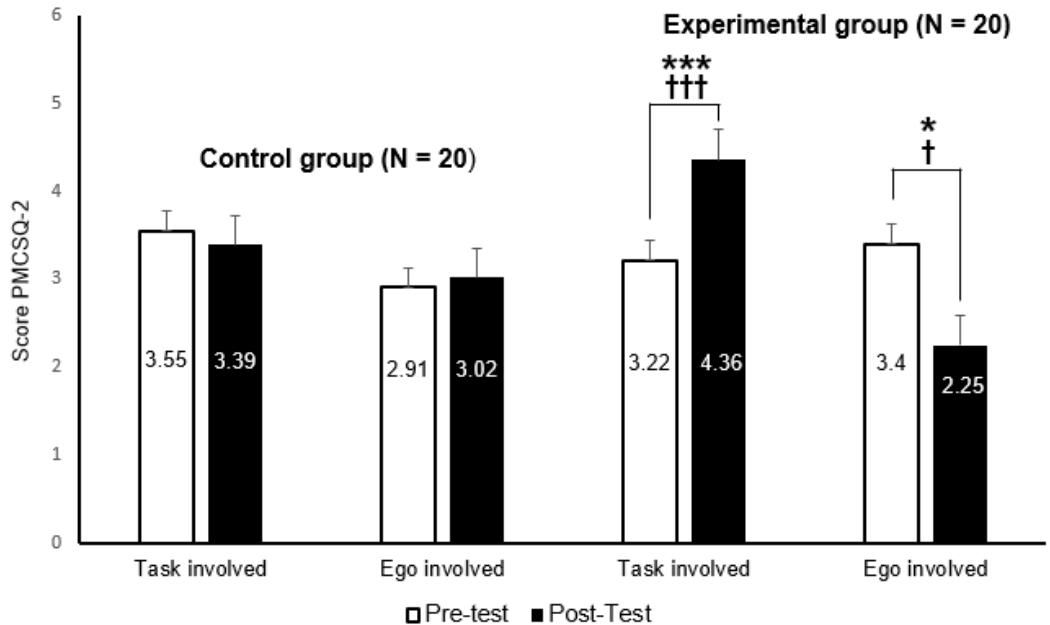
Figure 1. Comparison of the motivational climate before and after its implementation in the control group and the experimental group. *p < 0.05; **p < 0.01; ***p < 0.001; † small effect size (0.2 to 0.4); †† intermediate effect (0.5 to 0.7); ††† large effect